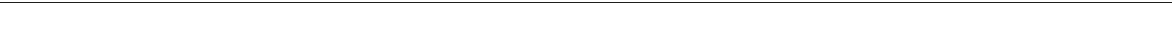
Fig. 6 USP52/ASF1A signaling axis is implicated in breast carcinogenesis. a Immunohistochemistry analysis of the expression levels of USP52 and ASF1A in different histologic types of breast tumors and adjacent normal mammary tissues. Representative images (×100, ×200, and ×400 magni fi cation) from these samples are shown. Scale bar, 50 μ m. b Scores of the stained sections from a were determined by evaluating the intensity of immunopositivity by Image-pro Plus software and are presented with box plots. ** P < 0.01, one-way ANOVA. The correlation coef fi cient and P -values were analyzed as indicated. c Colony formation assays of MCF-7 cells stably expressing USP52 shRNAs. Representative images from biological triplicate experiments are shown. ** P < 0.01, one-way ANOVA. d Colony formation assays of MCF-7 cells stably expressing the indicated genes and shRNAs. Representative images from biological triplicate experiments are shown. ** P < 0.01, one-way ANOVA. e Colony formation assays of MCF-7 cells stably expressing the indicated genes and shRNAs. Representative images from biological triplicate experiments are shown. ** P < 0.01, one-way ANOVA. f MCF-7 tumors with the indicated treatments were transplanted onto athymic mice and tumor volumes were measured weekly. Each bar represents the mean ± S.D. for different animal measurements ( n = 6). ** P < 0.01, two-way ANOVA. The levels of USP52 and ASF1A proteins in these tumors were examined by western